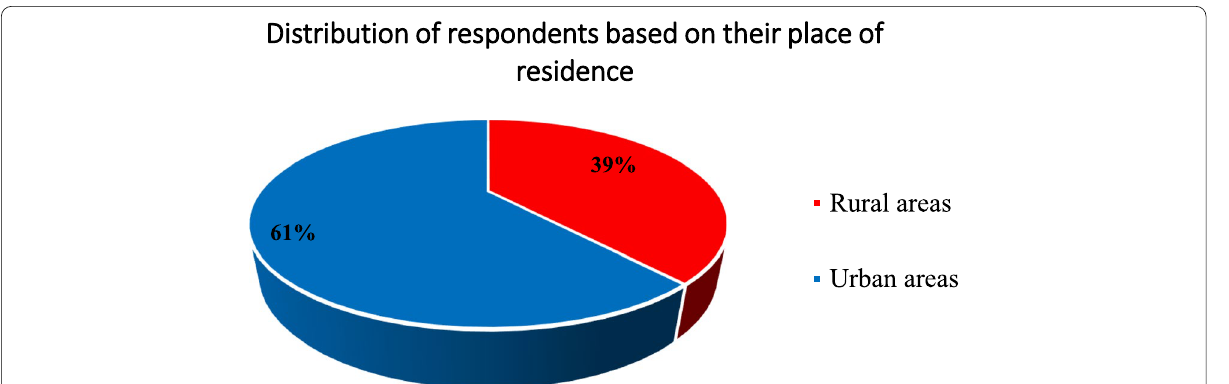
Fig. 3 Prevalence of TFSV among the harassed study participants based on their place of residence ( n